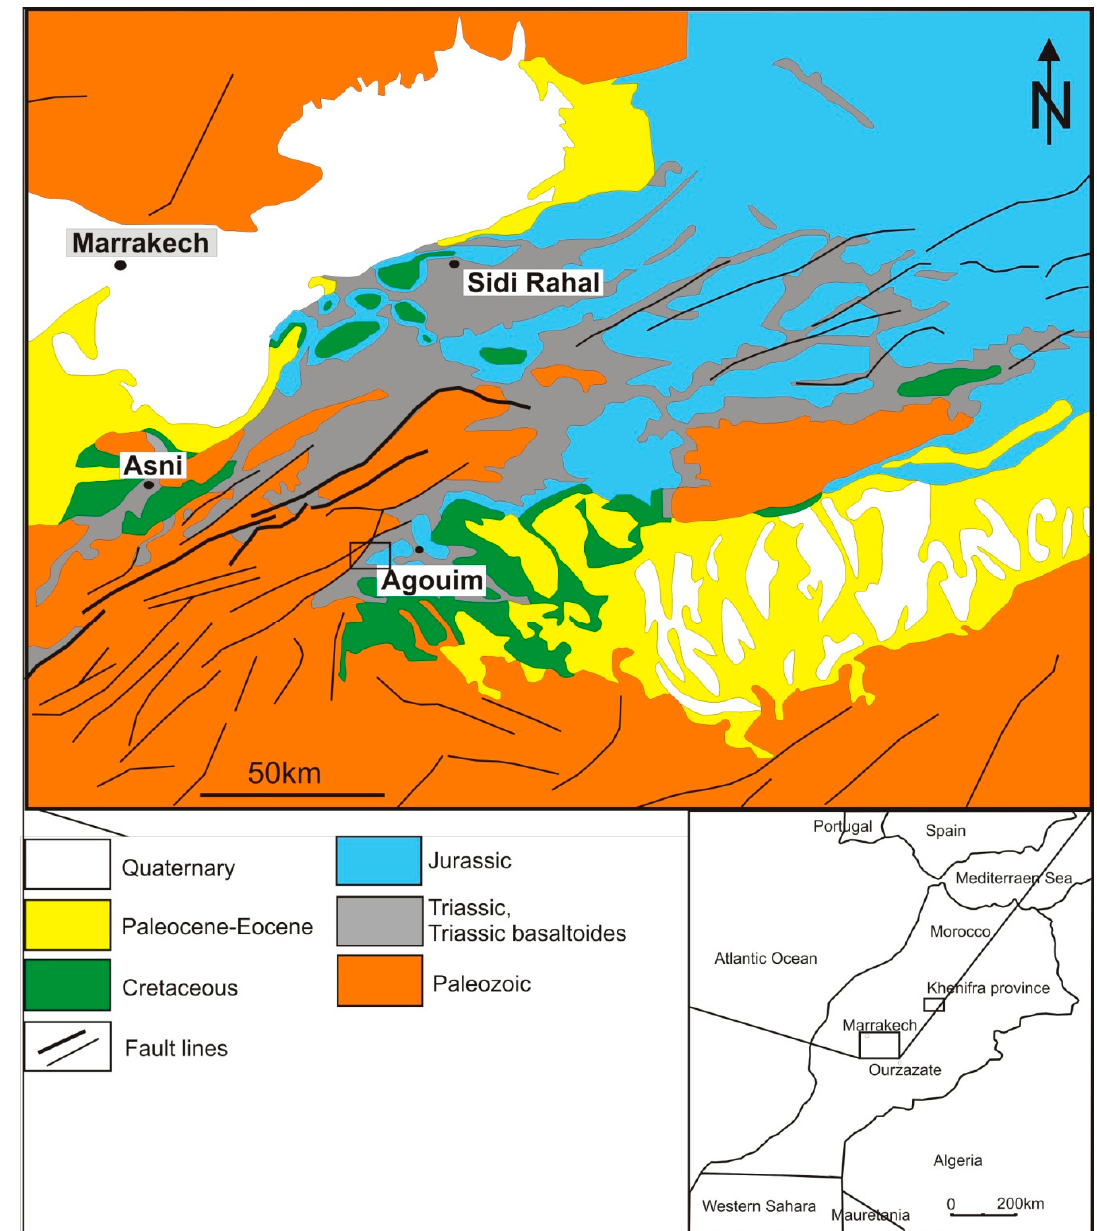
Figure 1. Simplified geological map of the Western Atlas area focusing on the studied agate occurrences (rectangles mark areas of study in Agouim and well as Kerrouchen in Khenifra). The agate deposit in the Kerrouchen–Ahouli area was found at the beginning of this century [15]. Sidi Rahal is a small village about 15 km east of Aït Ourir, which became known from a quarry That area is situated in the Kh é nifra province (Central Morocco), and borders the Middle Atlas on the of basalts with agate mineralization. Triassic basaltoides have a thickness up to 3.0 km in that region south, Rif Mountains on the north, and Wadi Muluja on the east. Agate samples are collected there [15]. This volcanic outcropping is half-moon shaped with a size of 110 × 70 km. Basaltoides frequently contain spherical or almond-shaped geodes filled with SiO 2 group minerals (agates, amethyst, etc.). Similar basaltic bodies are found in other part of the High Atlas Mts. The most common are in the vicinity of Agouim, where they build a mountain range parallel to the main Atlas range or occur along the road to Ouarzazate. Their thickness is up to few hundred meters, and their length is more than 70 km. Agates occur in practically all the basaltic suites in the area and few names are used to describe the localities (Agouim-Al Hama, Tizi-n-Tichka, and Agouim-Sour). Our studied samples were collected in the basaltoids mountain range on the left side of the road connecting Agouim and Lake Ifni close to village Sour. Basaltic rocks outcrop are smaller in the Asni area, where they cover the area up to a few km long and are about 300 m thick. Generally, at least four different basaltic suites seem to be recognized in the High Atlas Mts. One of the most interesting regions for agates is